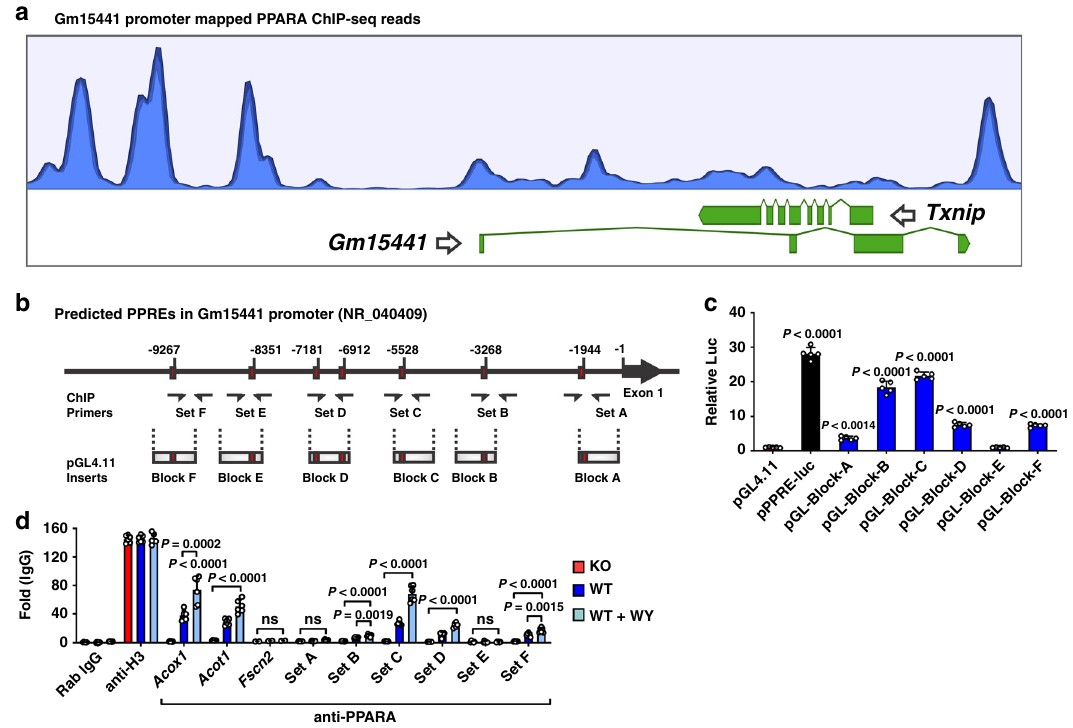
Fig. 3 LncRNA Gm15441 is a direct PPAR α target gene. a PPAR α ChIP-seq read peaks from agonist (GW7647)-treated mouse liver. b Schematic representation of seven PPRE sequences found within the Gm15441 promoter ( − 10 kb). ChIP primer binding sites and reporter gene construct inserts are shown. c Luciferase-based reporter assays identi fi ed several functional PPREs within the Gm15441 promoter, based on n = 3 replicates. d PPAR α ChIP assays assessed PPRE binding in liver samples from Ppara + / + and Ppara − / − mice treated with WY-14643. Experiments were performed with at least four different livers. Rabbit IgG and antibody to histone H3 were used as negative and positive controls, respectively. Each data point represents the mean ± SD for n = 5 liver samples. Adjusted p values, provided in the panels, as determined by ANOVA with Tukey ’ s multiple comparison correction, one-sided for comparisons to pGL4.11 empty vector ( c ) or as indicated ( d ). ns not signi fi